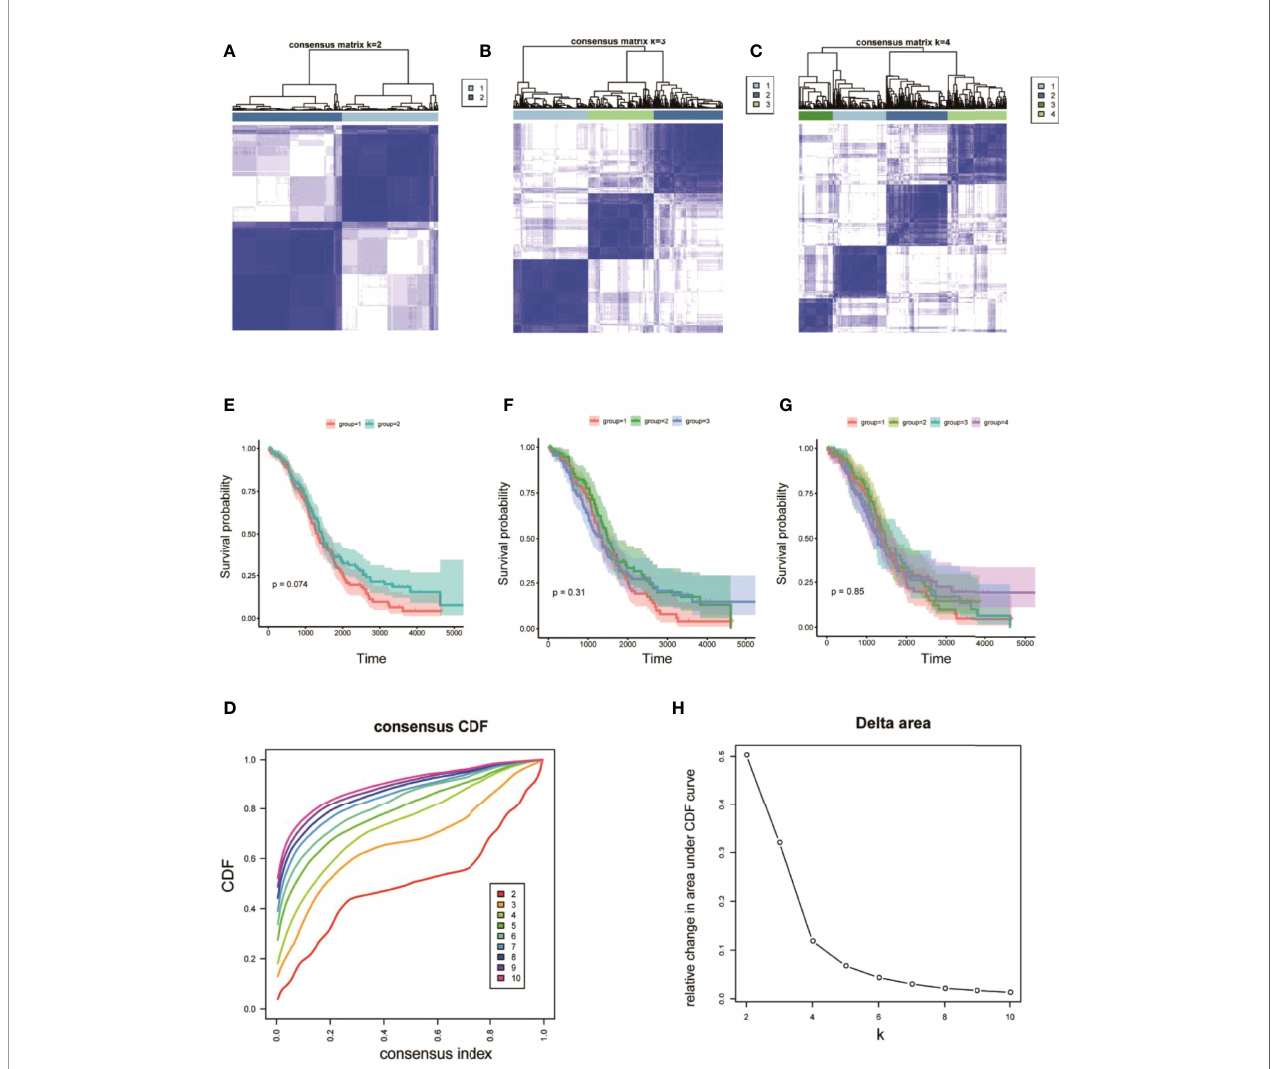
FIGURE 5 | Heterogeneous clustering analysis for 60 ferroptosis-related gene expression values. (A – C) Clustering results, with classi fi cation k values of 2, 3, and 4, respectively; (D) CDF curve distribution of consistent clustering; (E – G) survival analysis of OC samples, with classi fi cation k values of 2, 3, and 4, respectively; (H) distribution of AUC under the CDF curve of consistent